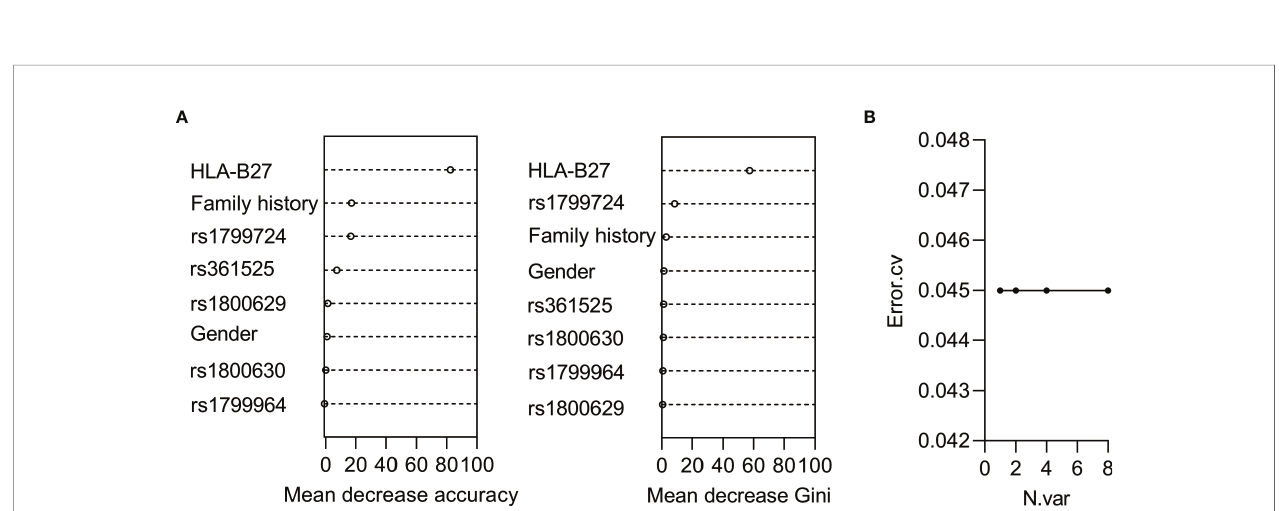
FIGURE 2 | Predictive classi fi er for ankylosing spondylitis (AS) based on random forest algorithm. (A) Receiver-operating characteristic curve (ROC) for the training group. (B) Scatter plot of the probability of AS in the training group. (C) ROC for the validation group. (D) Scatter plot of the probability of AS in the validation group. AUC, area under ROC; PPV, positive predictive value; NPV, negative predictive value; ACC, accuracy; LDH, patients with lumbar disc herniation. **** p < 0.0001 by Mann – Whitney test or Kruskal – Wallis test.